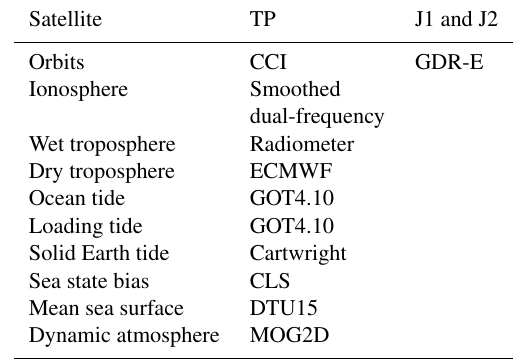
Table 1. List of geophysical corrections and orbits applied in this